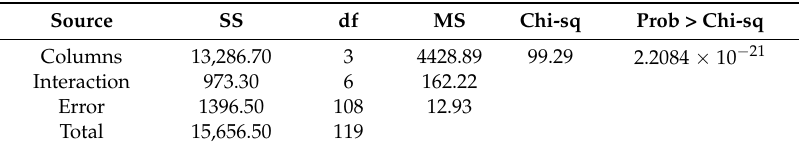
Table 11. Friedman test table for the specificity metric.